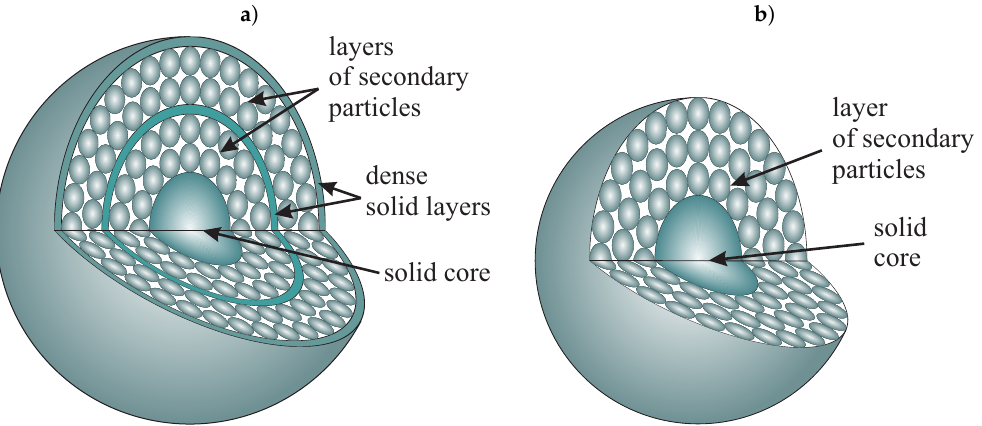
Figure 7. A schematic representation of the multi-layer structure of silicon dioxide particles: a two-layer model of the large particle ( a ), and a shell-like model of the silica grown by the multistage SFB method ( b